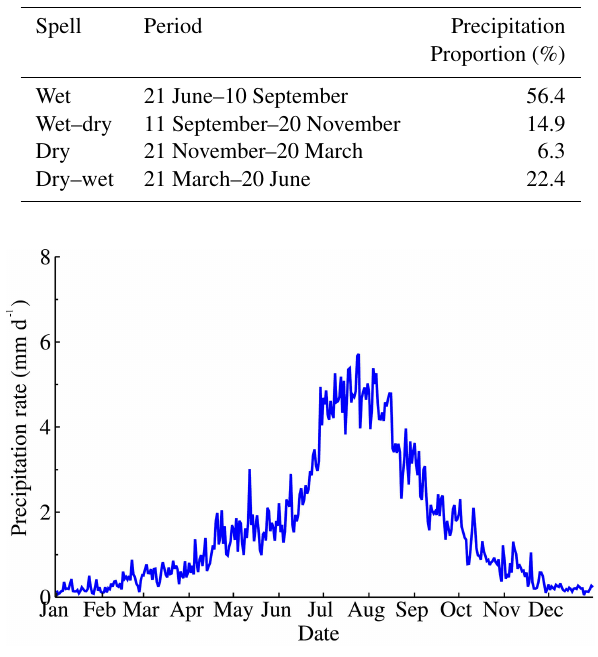
Figure 5. Temporal evolution of daily precipitation rate in northern China, averaged from 1961 to